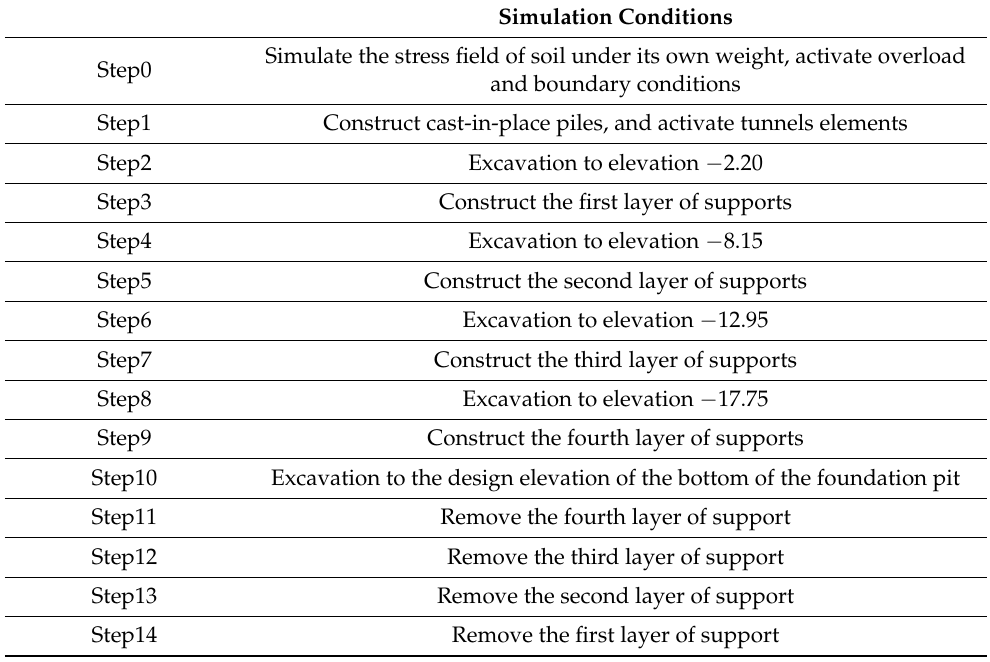
Table 1. Simulation conditions of finite element